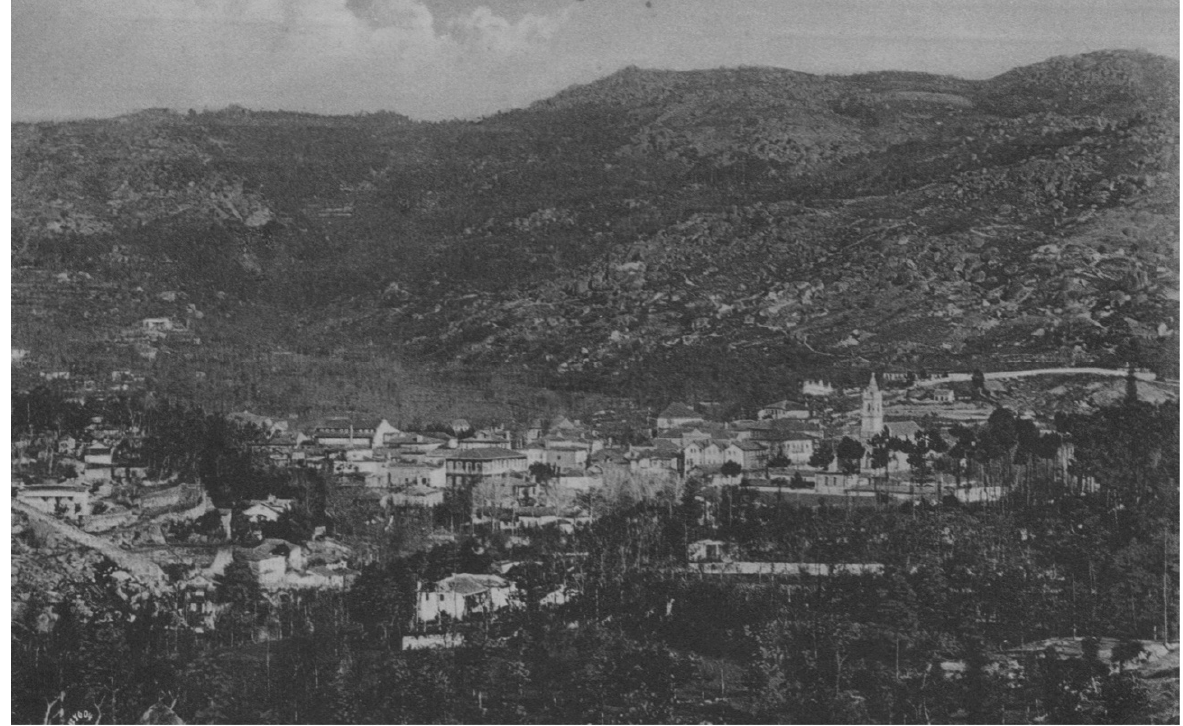
Figure 9. View of the surroundings of Vizela, with the mountains devoid of large vegetation (image obtained from a postcard from the private collection of the author).